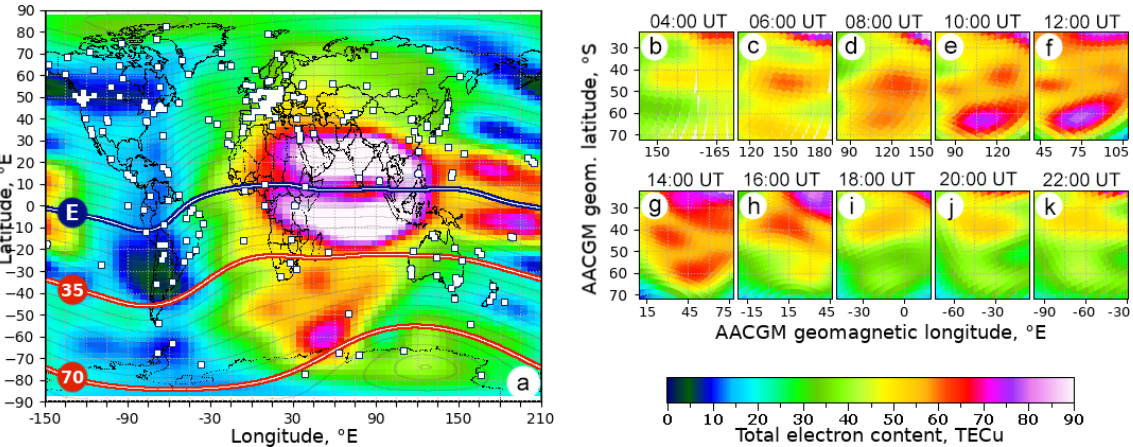
Figure 1. (a) An intense LTE observed at 10:00UT on 5 April 2014 near Antarctica, and (b–k) its development during a day in geomagnetic coordinates. (a) The LTE develops along geomagnetic parallels in a region between 35 and 70 ◦ S (red lines).